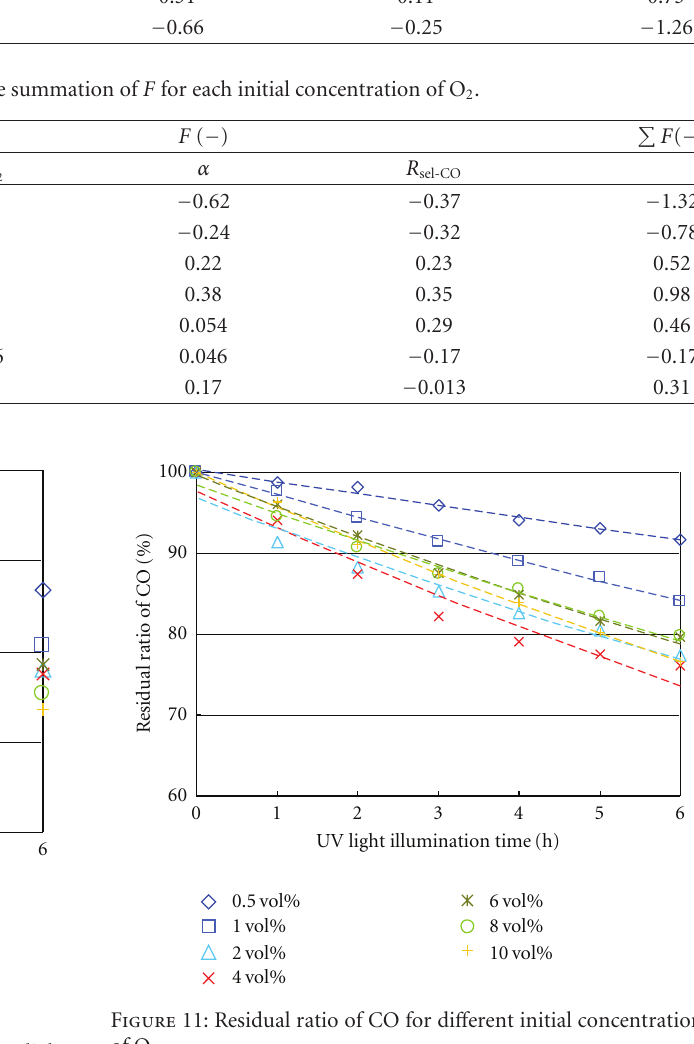
Figure 10: Change of concentrations of CO with UV light illumination time for di ff erent initial concentrations of O 2 .